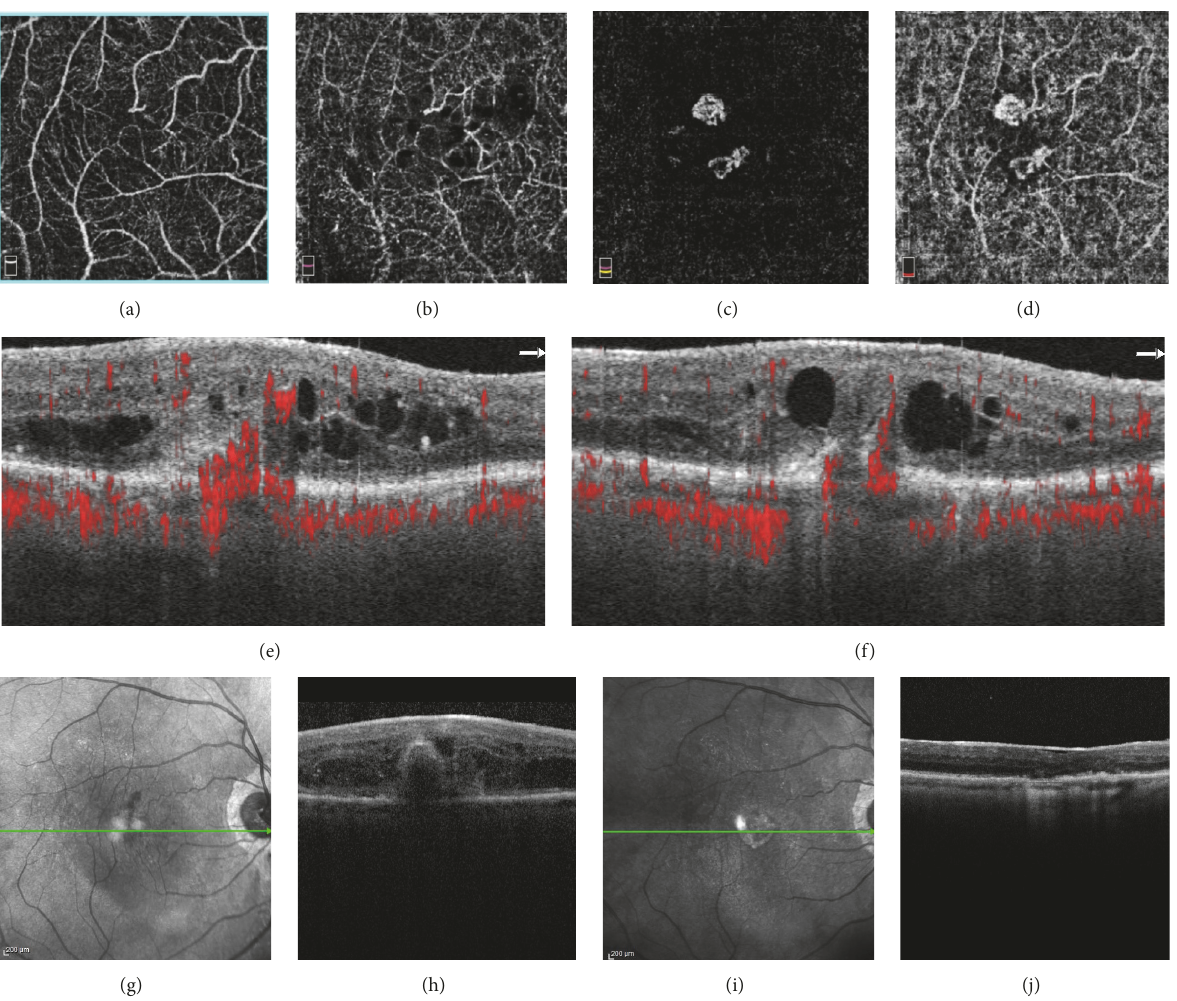
Figure 2: (a)-(d) Optical coherence tomography angiography images (6 × 6 mm) revealed the progression of the tuft-shaped lesion from the superficial layer to choroid capillary. (a) Superficial capillary plexus segmentation. (b) Deep capillary plexus segmentation. (c) Outer retinal layer segmentation. (d) Choriocapillaris segmentation. (e)-(f) B-Scans optical coherencetomography angiography showed clearly two distinct intraretinal neovascularizations originated in the superficial layer descending into a tuft-shaped lesion toward the sub-RPE space, respectively above (e) and under (f) the fovea. (g)–(h) Spectral Domain-Optical CoherenceTomography at baseline.(i)–(j) Spectral Domain- Optical Coherence Tomography after